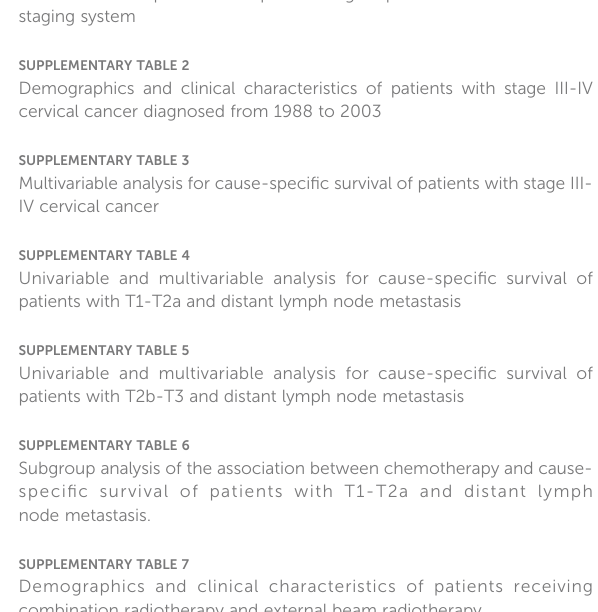
SUPPLEMENTARY TABLE 7 Demographics and clinical characteristics of patients receiving combination radiotherapy and external beam radiotherapy SUPPLEMENTARY TABLE 8 Demographics and clinical characteristics of patients receiving combination radiotherapy and external beam radiotherapy for the propensity – score matched